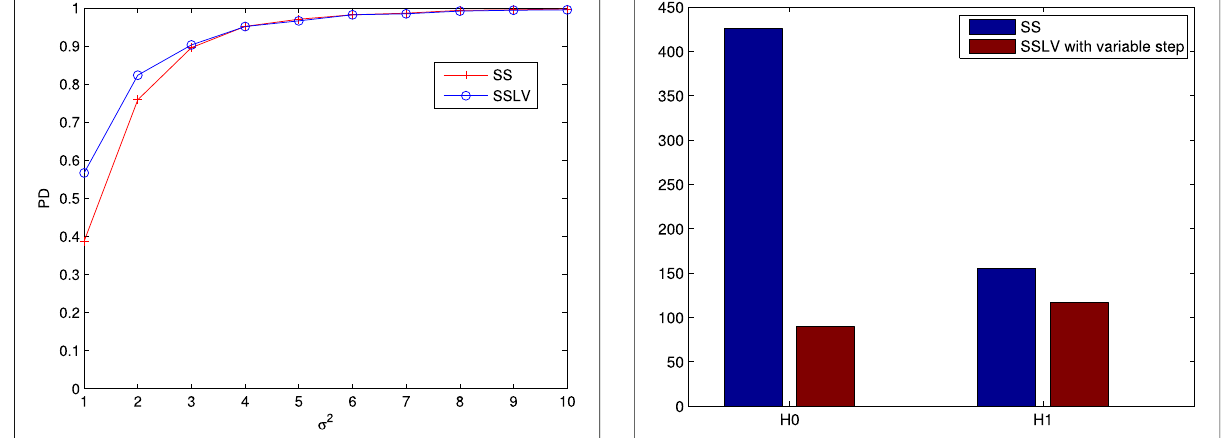
Fig. 7 Probability of detection for MA versus σ 2 . Here, we have N (cid:2) = 27, b = 5, σ w 2 = 4, k = 8, p fa = 0.05, and f ov = 5. Simulations are based on 5000 runs